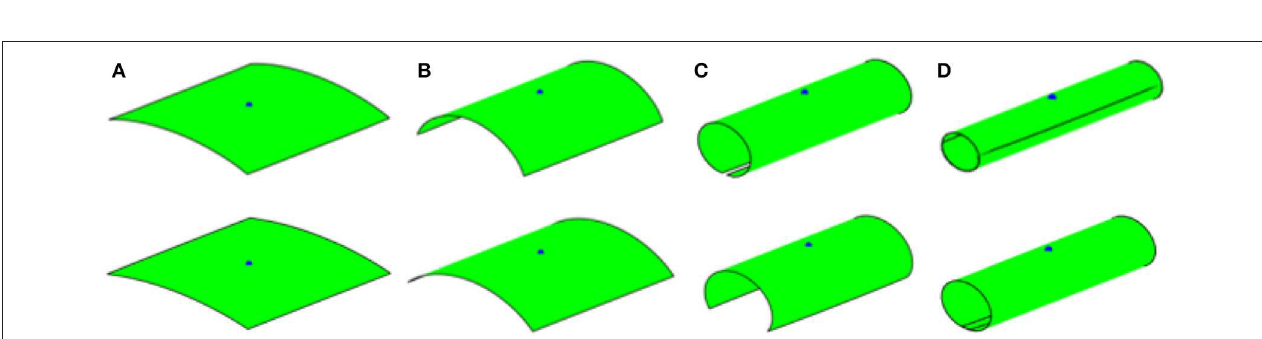
FIGURE 7 | Folding of square plate, m 2 = 0. Top: with poisson’s effect; bottom: without poisson’s effect. (A) Electric field 25 MV/m; (B) electric field 43 MV/m; (C) electric field 68 MV/m; and (D) electric field 86 MV/m.